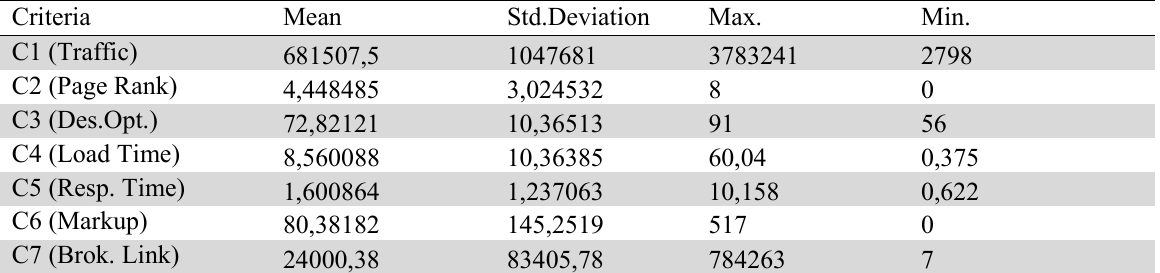
The Descriptive Statistics of the Data Sets Criteria